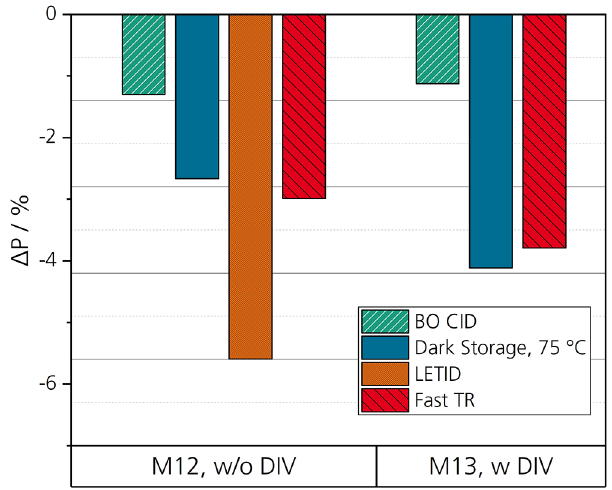
Fig. 11. Relative changes of P MPP at STC of two PV modules, which were tested under Dark Storage at 75 ° C with (M13) and without dark IV monitoring (M12) after BO-CID, Dark Storage, CID at 75 ° C and Temporary